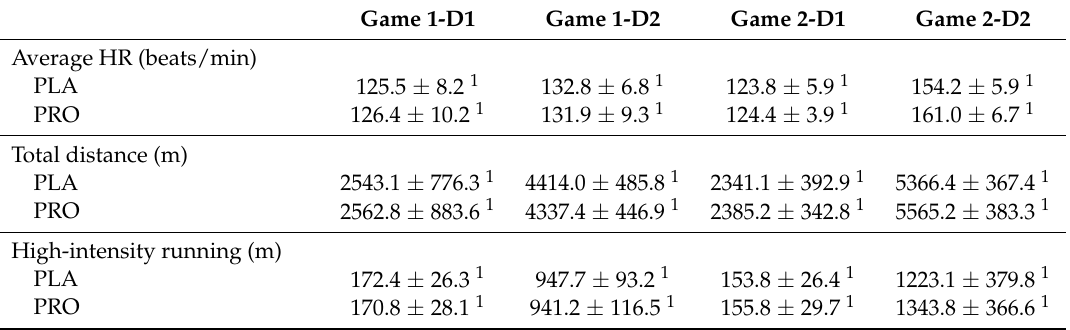
Table 4. Changes in practice field activity in response to protein and placebo